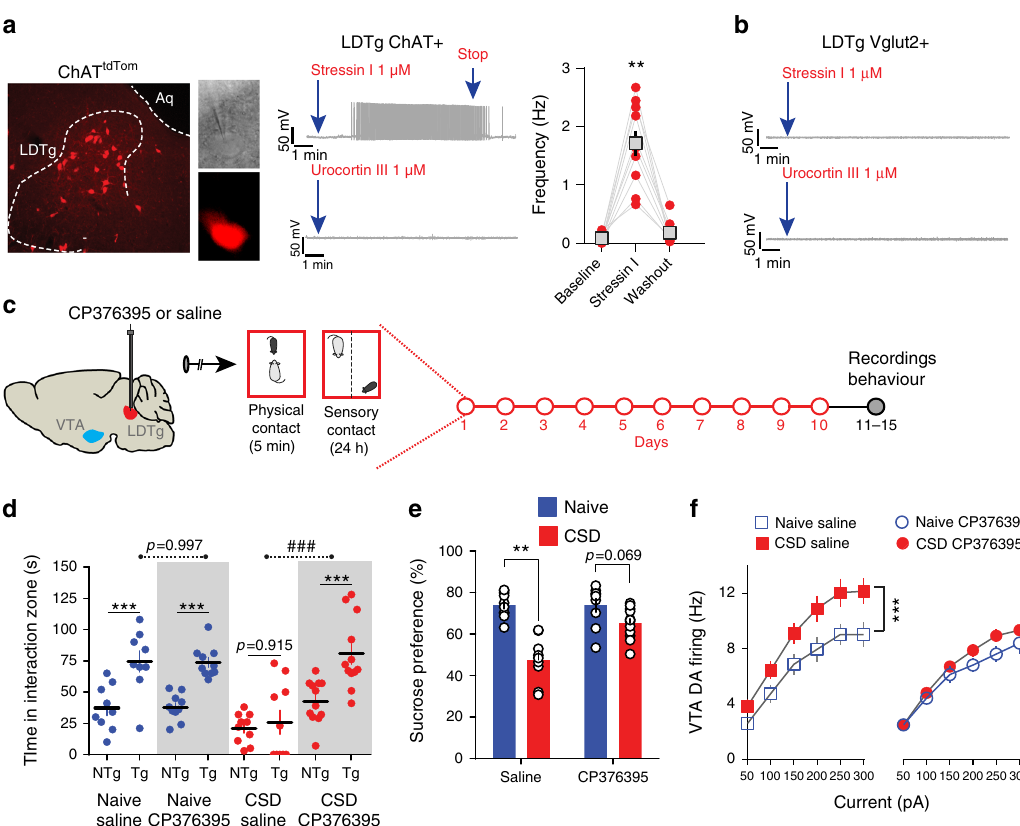
Fig. 5 CRF-1 receptors expressed in cholinergic LDTg neurons mediate stress-induced depressive-like behaviors and dysregulation of VTA DA neurons. a Confocal image depicting the LDTg in a ChAT-Cre::tdTtomato (ChAT tdTom ) mouse coronal section. Visualization of tdTomato-tagged cholinergic neurons in the electrophysiological set-up during patch-clamp recordings. In current-clamp mode, most cholinergic neurons were silent, but